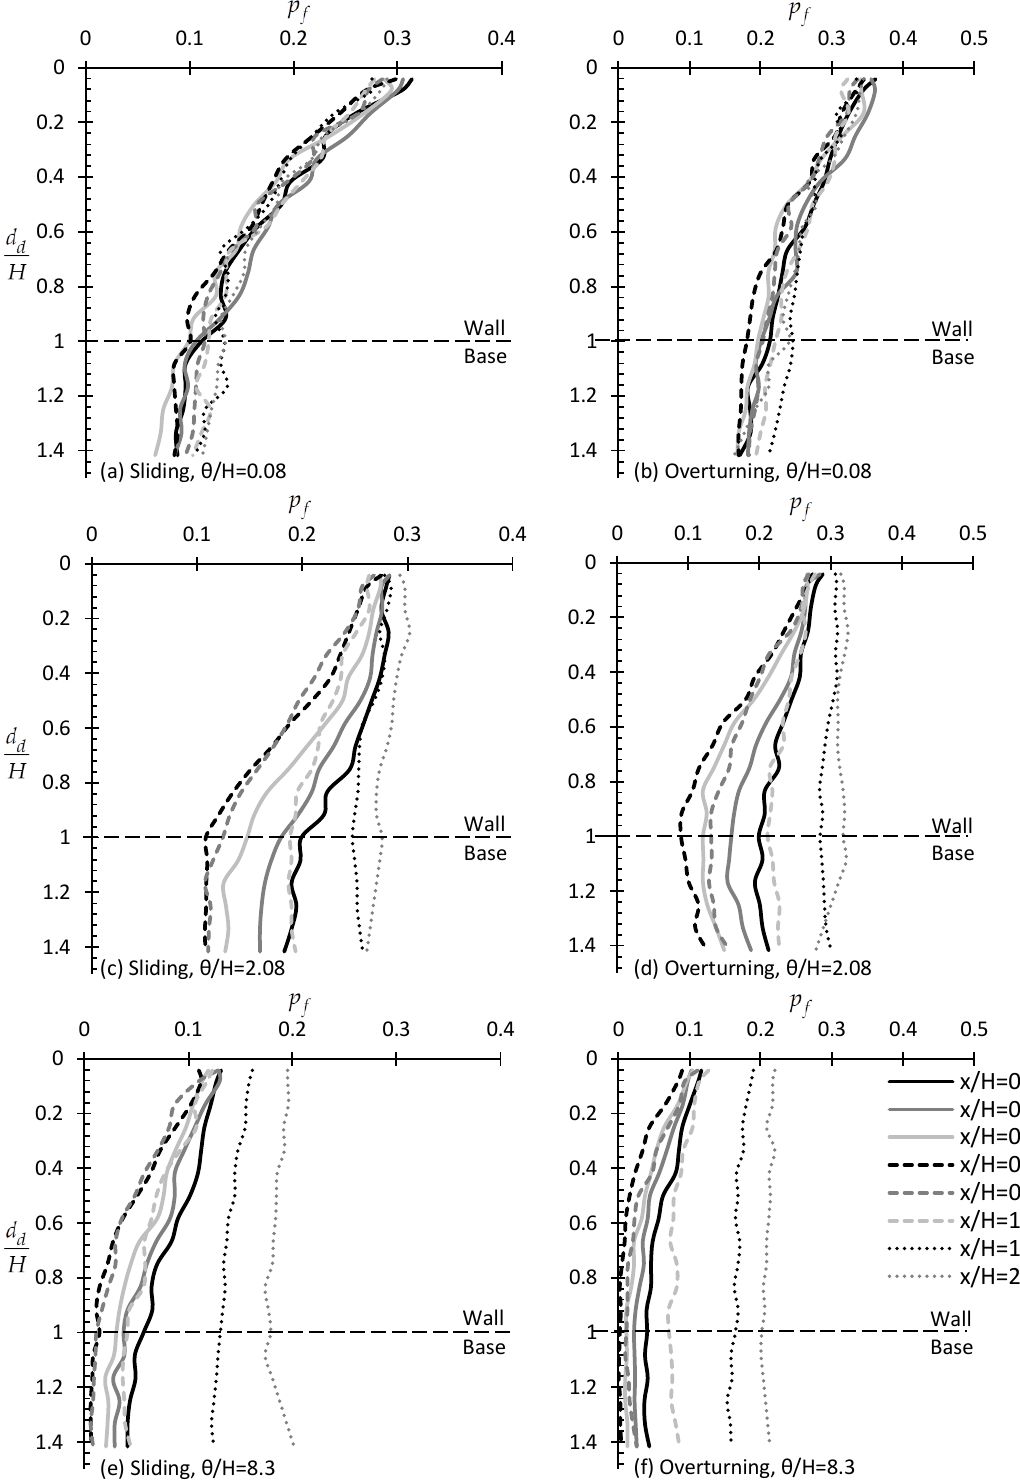
Figure 11. p f − d d / H curves for various x / H and θ / H values for both the sliding ( a , c , e ) and overturning Figure 11. f p - d d H curves for various x H and H  values for both the sliding ( a , c, e ) and modes of failure ( b , d , f overturning modes of failure ( b , d , f ).